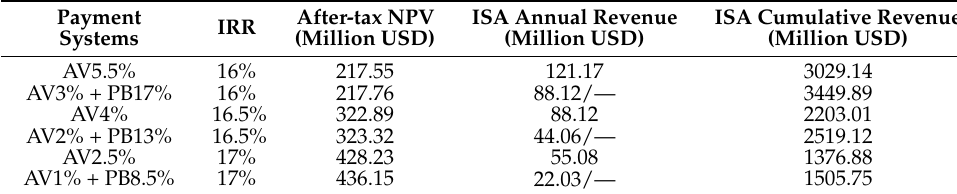
Table 11. Economic metrics of the project with different payment systems.